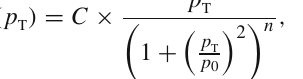
Fig. 3 Inclusive J /ψ cross sections as function of p t ( left ) and y ( right ) in pp collisions at positive- y measurements with respect to y = 0 the slope of the p t -differential cross section is visible for p t > 10 GeV/ c . This change in slope is attributed to the onset of the contribution from non-prompt J /ψ to the inclu- sive cross section as it will be discussed in Sect. 4.3.